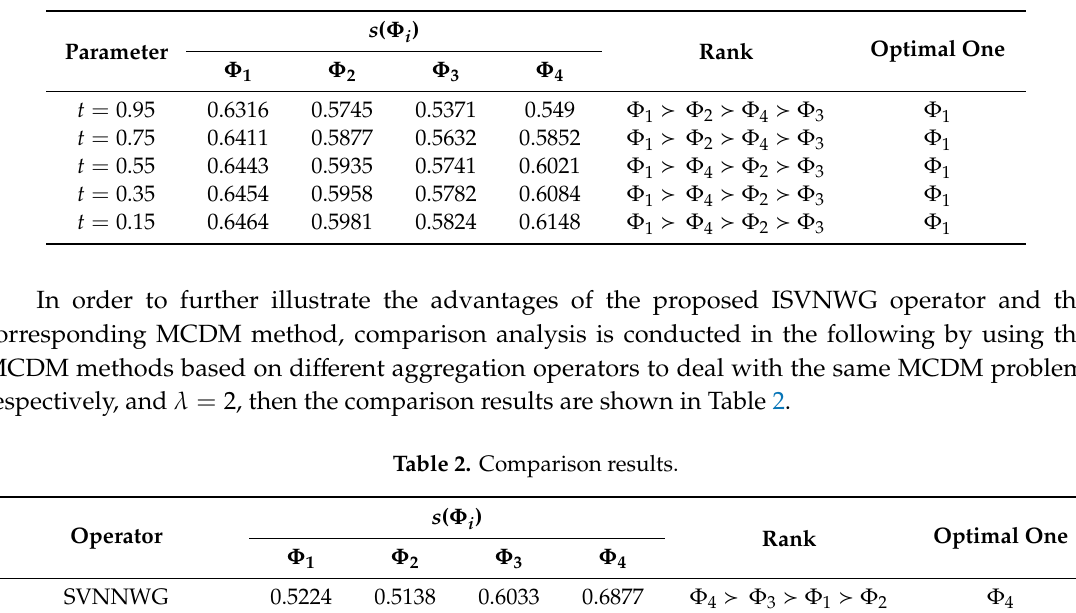
Table 1. Sensitivity analysis.